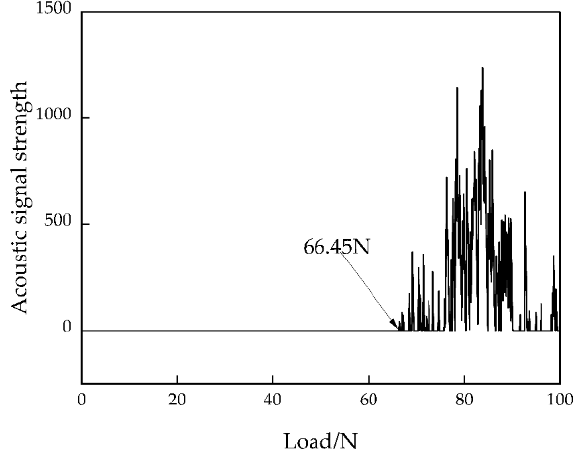
Figure 10. Acoustic signal curve of scratches.